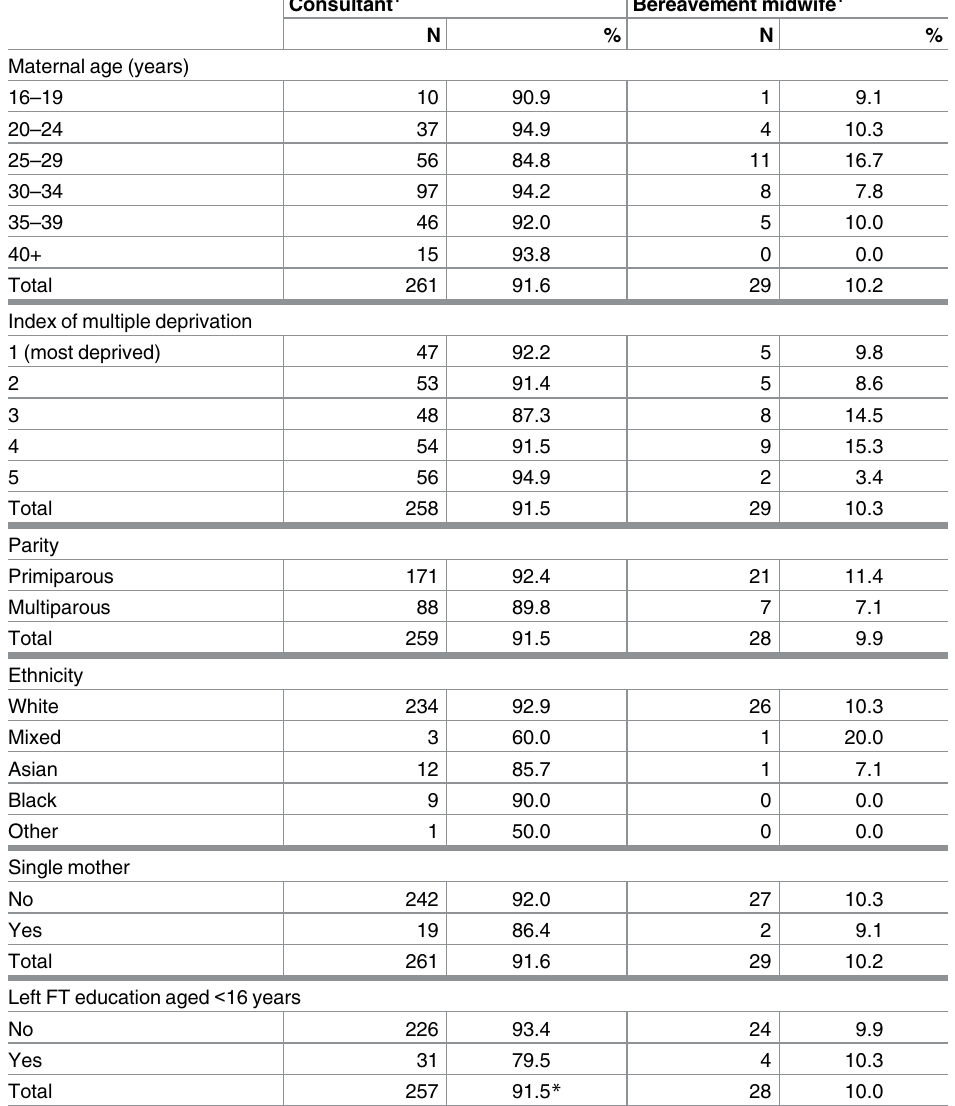
Table 6. How post-mortem results were conveyed, by consultant and/or by bereavement midwife 1 (as indicated by the